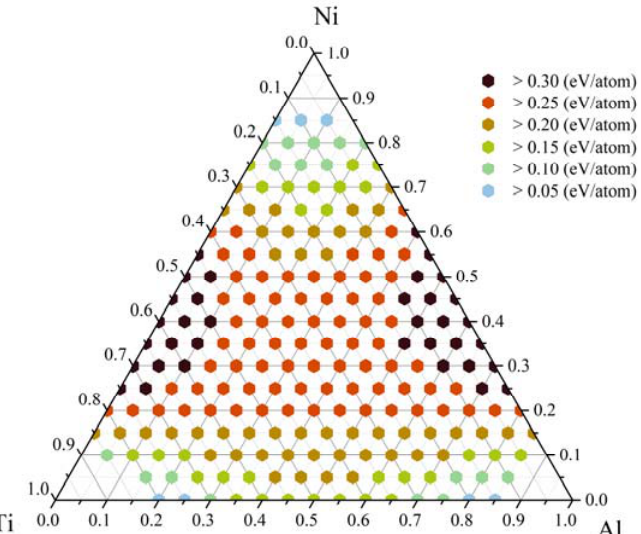
Figure 4. Amorphous driving forces for the transition of solid solutions to amorphous solutions in the Al-Ni-Ti system, with compositions located in the glass-formation region derived from MC and MD simulations.